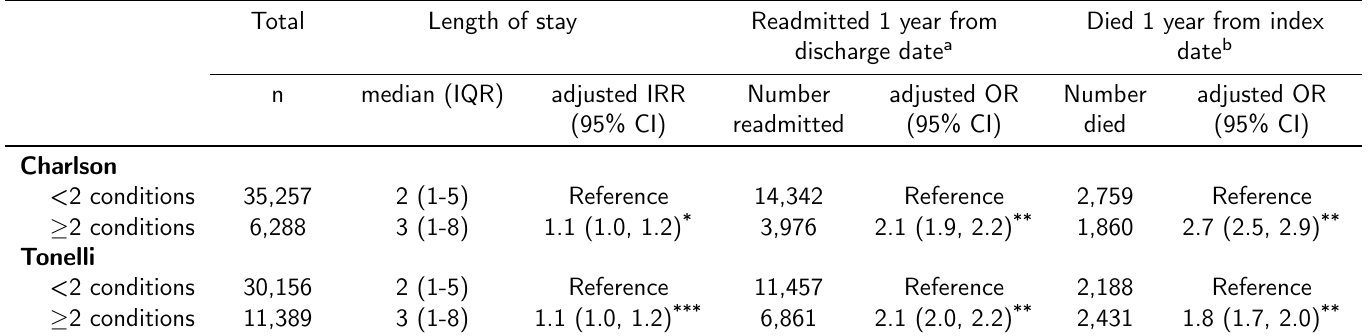
Table 3: Association between multimorbidity and length of stay, readmission and mortality